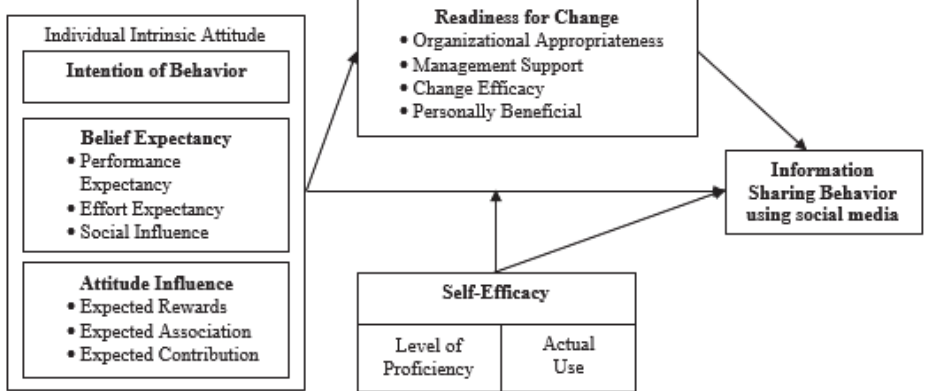
Fig. 1. New Integrate Model of Information Sharing Behavior Using Social